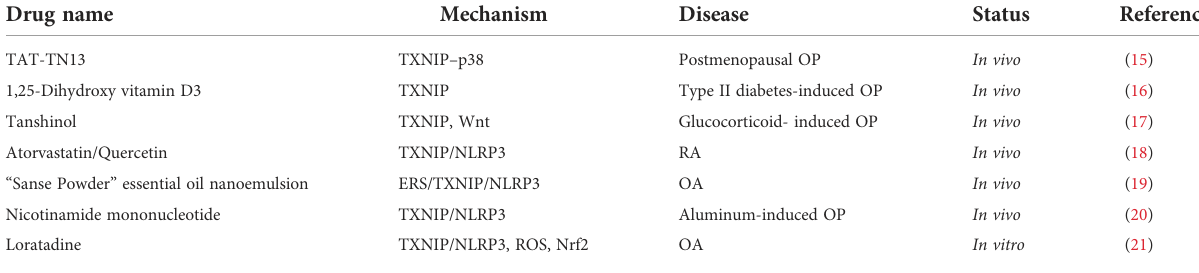
TABLE 1 Application of TXNIP regulators in bone metabolic